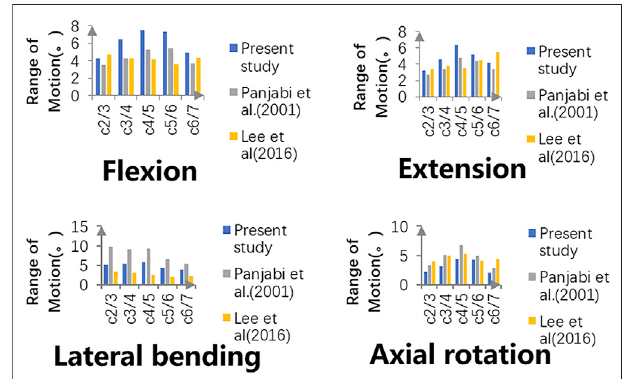
FIGURE4| IntersegmentalROMsoftheintactmodelarecomparedwith those of previously published studies, and validity has been proven.